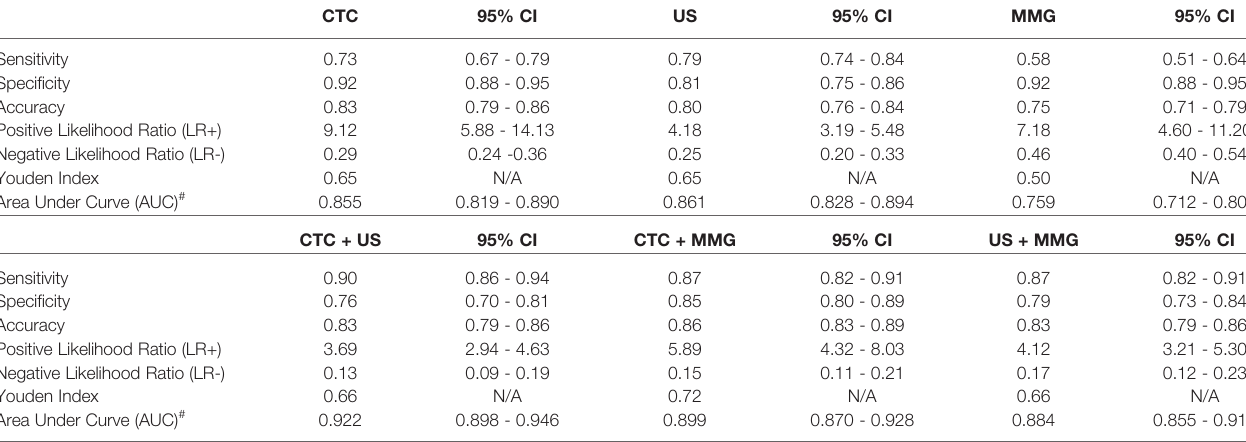
TABLE 2 | Diagnostic power of CTC, US and MMG in breast cancer